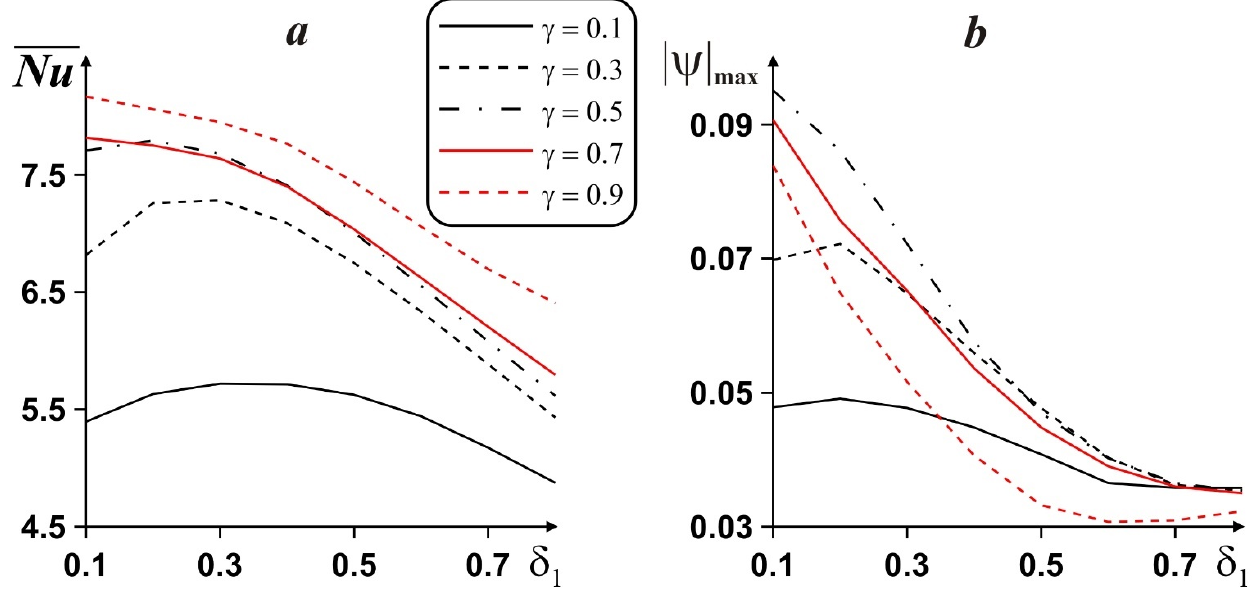
Figure 7. Dependence of mean Nusselt number ( a ) and fluid flow rate ( b ) for one porous fin on distance from the bottom wall to the fin and length of the fin, for Da = 10 − 2 .